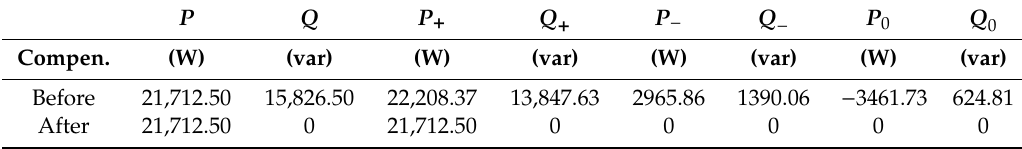
Table 7. Comparison of powers, before and after total